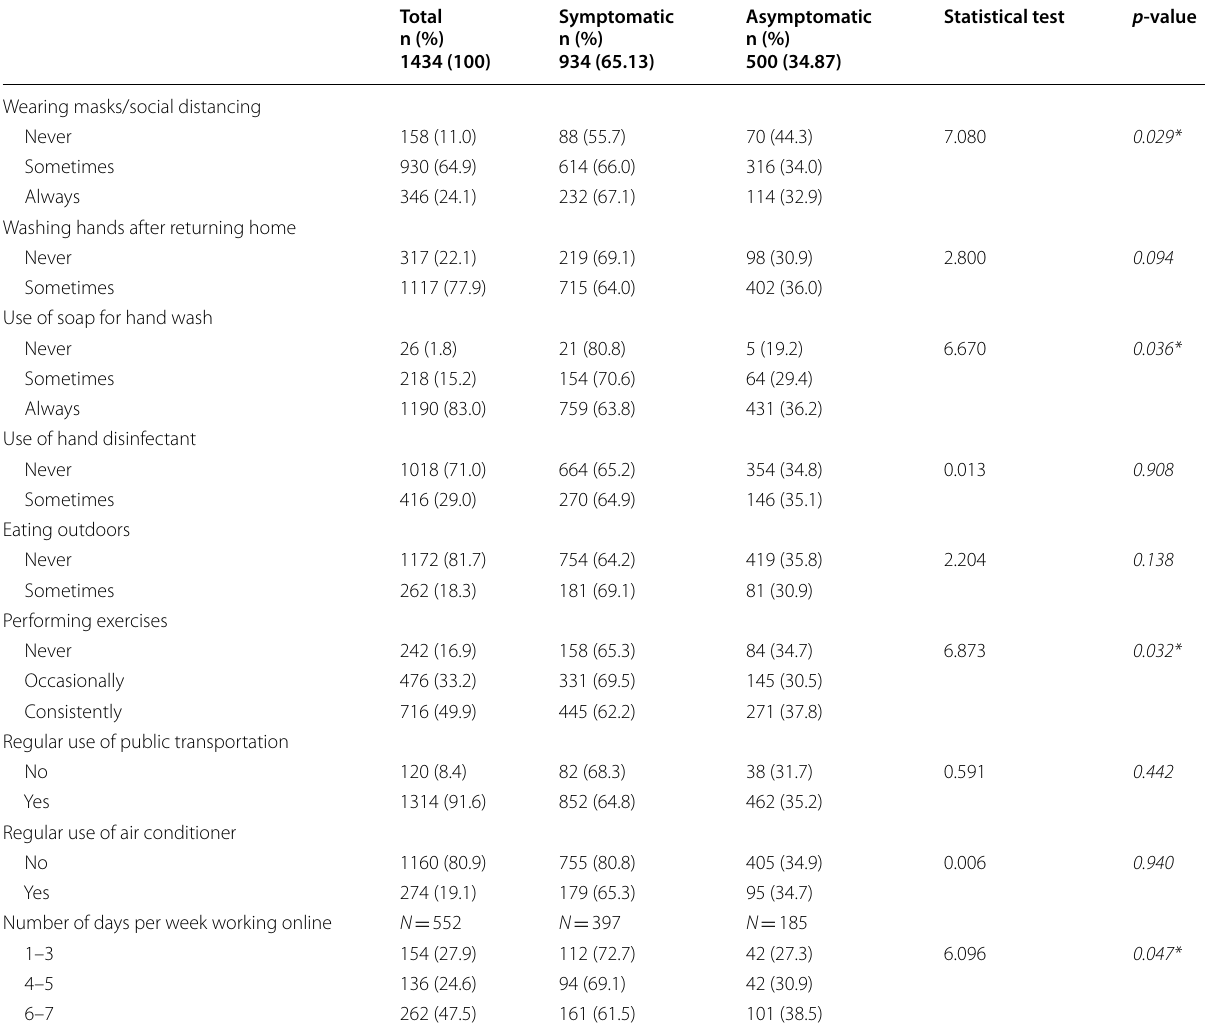
Table 3 Distribution of the symptomatic and asymptomatic participants in relation to their habits and applied infection control